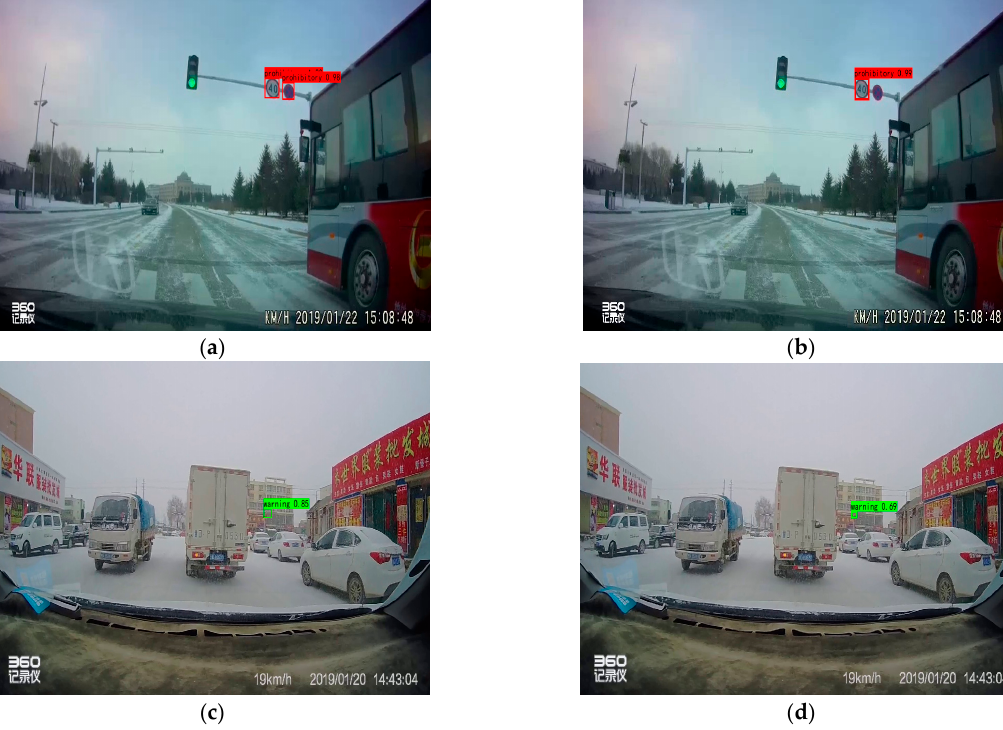
Figure 17. Comparison results of different algorithms in snowy weather, where ( a , c ) are the results of TSR-YOLO, ( b , d ) are the results of